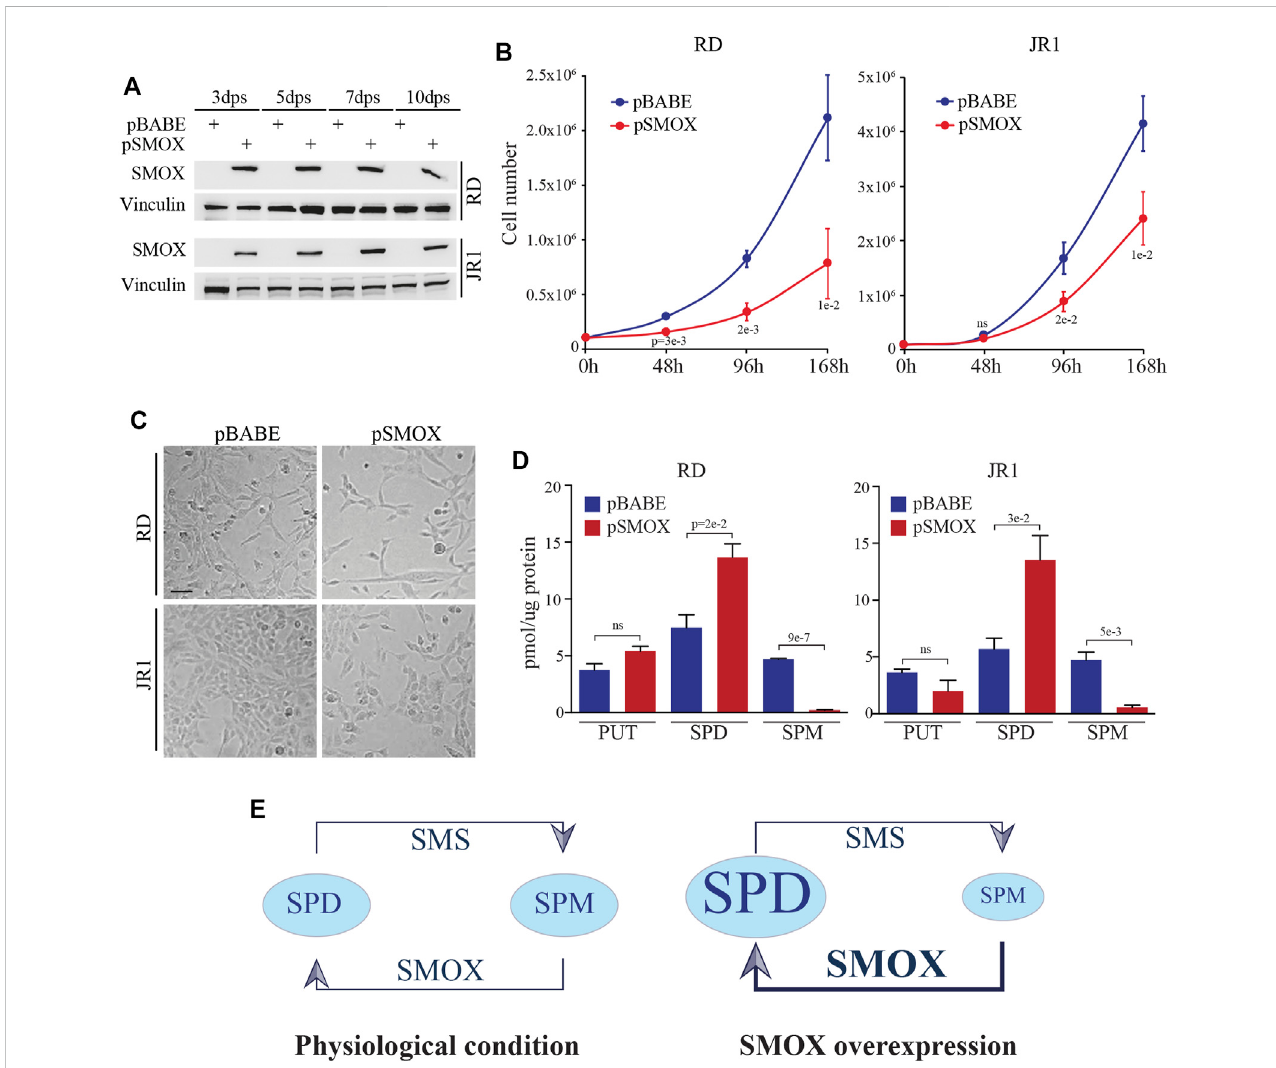
FIGURE 2 SMOX overexpression in FN-RMS cell lines reduces cell proliferation. (A) Representative western blot ( n = 3 independent biological replicates) depicts SMOXoverexpressionat3,5,7,and10 dayspostselection(dps)withpuromycininRDandJR1.Vinculinwasusedasloadingcontrol. (B) Growth-curveanalysis of RD and JR1 at 0, 48, 96, and 168 h post seeding. Graph represents the mean of three independent experiments ±SD, Student two-tailed t -Test. Exact p -values are reported in the fi gure. (C) Representative images of SMOX overexpressing-RD and -JR1 96 h post seeding. Scale Bar = 100 μ m. (D) Histograms of putrescine (PUT), spermidine (SPD) and spermine (SPM) concentrations expressed as pmoles/µg of protein in SMOX overexpressing-RD and -JR1 cells. Graph represents the mean of three independent experiments ±SD, Student two-tailed t -Test. Exact p -values are reported in the fi gure. (E) Schematic representation of SPD and SPM concentration balance in our experimental condition. In physiological conditions (left) SMS and SMOX enzymes maintain the balance between SPM and SPD concentration. SMOX overexpression (right), induces an imbalance shifts making the SPD the predominant